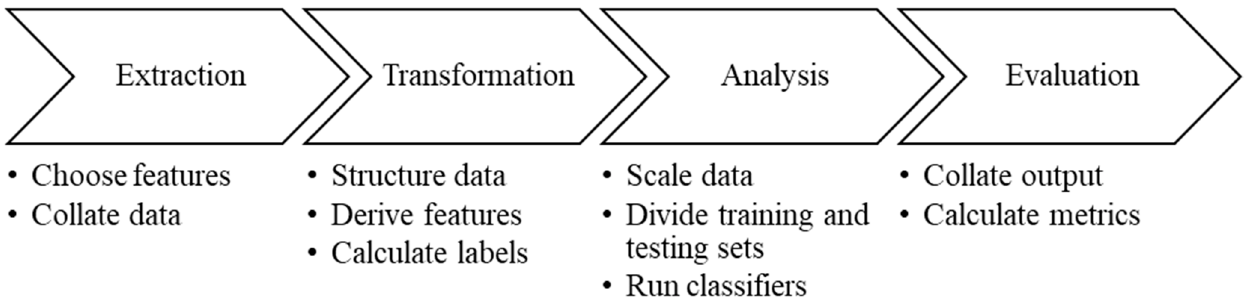
Figure 1. Analysis work-flow.